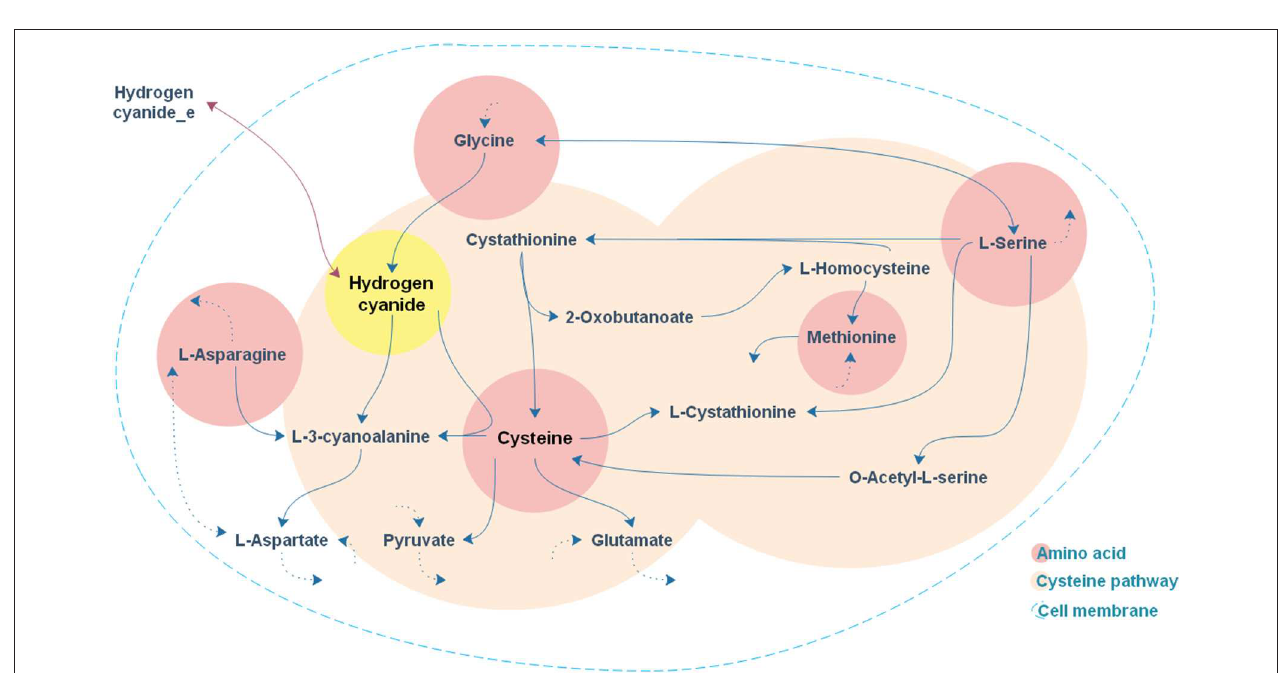
FIGURE 4 | A general overview of the cysteine pathway in accordance with cyanide formation.